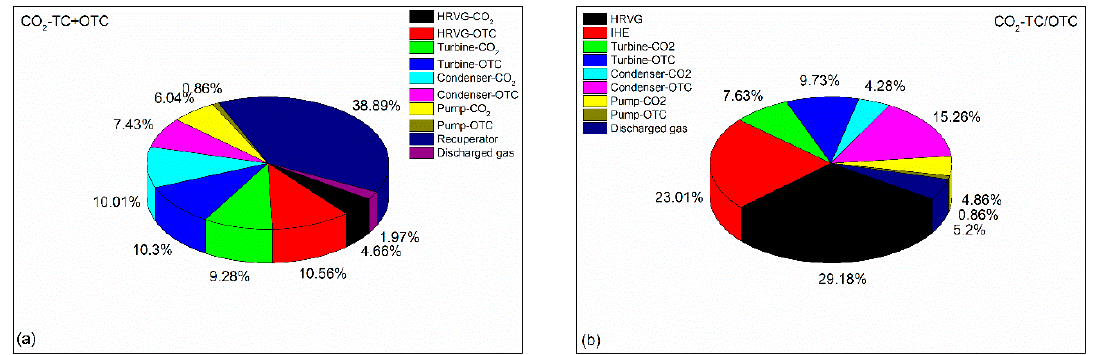
Figure 15. Distribution of exergy loss in each component of the combined cycle ( a ) CO 2 -TC+OTC; ( b ) CO 2 -TC/OTC.